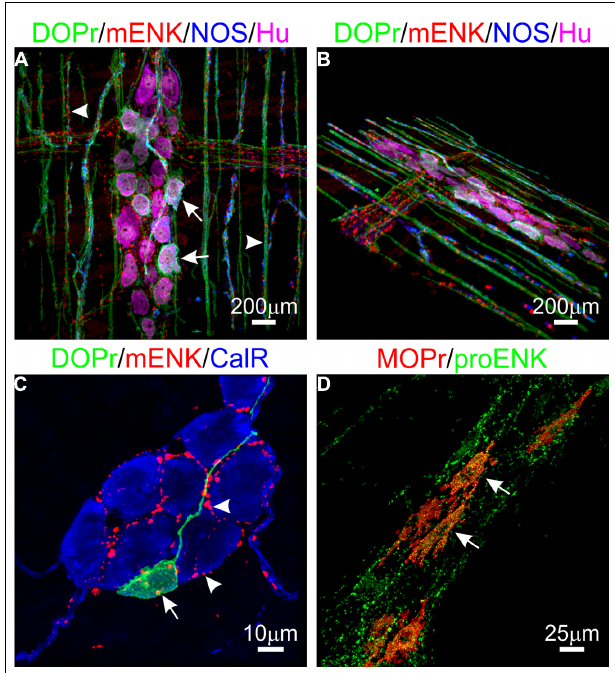
FIGURE 1 | Expression of opioid receptors (ORs) and enkephalin in the enteric nervous system. (A,B) Distribution of the delta opioid receptor (DOPr, green), met-enkephalin (mENK, red), nitric oxide synthase (NOS, blue), and the pan-neuronal marker HuC/D (Hu, magenta) in the myenteric plexus (arrows) and circular muscle nerve fibers (arrowheads) of the mouse distal colon. (C) Example of a DOPr-positive submucosal neuron (arrow) and association with mENK-immunoreactive nerve varicosities (arrowheads) in the mouse distal colon. (D) Overlap between immunoreactivities for the Mu opioid receptor (MOPr, red) and proenkephalin (proENK, green) in myenteric neurons of the guinea pig ileum. Images have been modified using Imaris 7.4.2 software (Bitplane). Scale bars are as